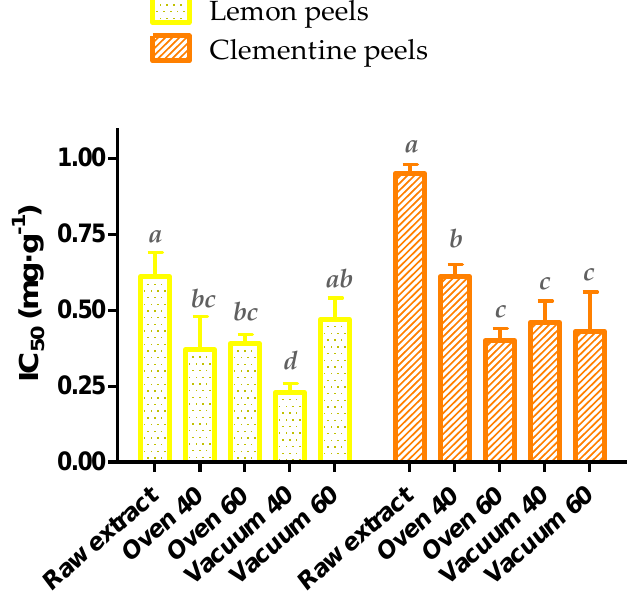
Figure 2. Antioxidant capacity based on DPPH assay of raw and dried extracts with different treatments of lemon and clementine peels. Data with different superscripts are significantly different at p -value < 0.05, according to one-way ANOVA and Fisher’s LSD test. Concerning the oven-dried clementine peel extracts, a decrease in IC 50 was found with rising temperatures, as higher temperatures may cause the release of some phenolic acid and flavonoid complex chains, as well as reduce the activity of polyphenol oxidase [17]. However, this pattern was not reported in vacuum-dried peel extracts, since the time required to reach total dryness was considerably lower (<7 h). Similarly, Xu et al. reported an increase in the total antioxidant activity of oven-dried grapefruit peels when the tem- perature was increased from 90 ◦ C to 120 ◦ C [26]. Inversely, no difference was observed for lemon peel extracts in both oven-dried samples, while a 62% gain in DPPH scavenging activity ( p -value < 0.05) was found for the extract dried under vacuum at 40 ◦ C, indicating that this may be the most suitable method for drying the latter. Moreover, this